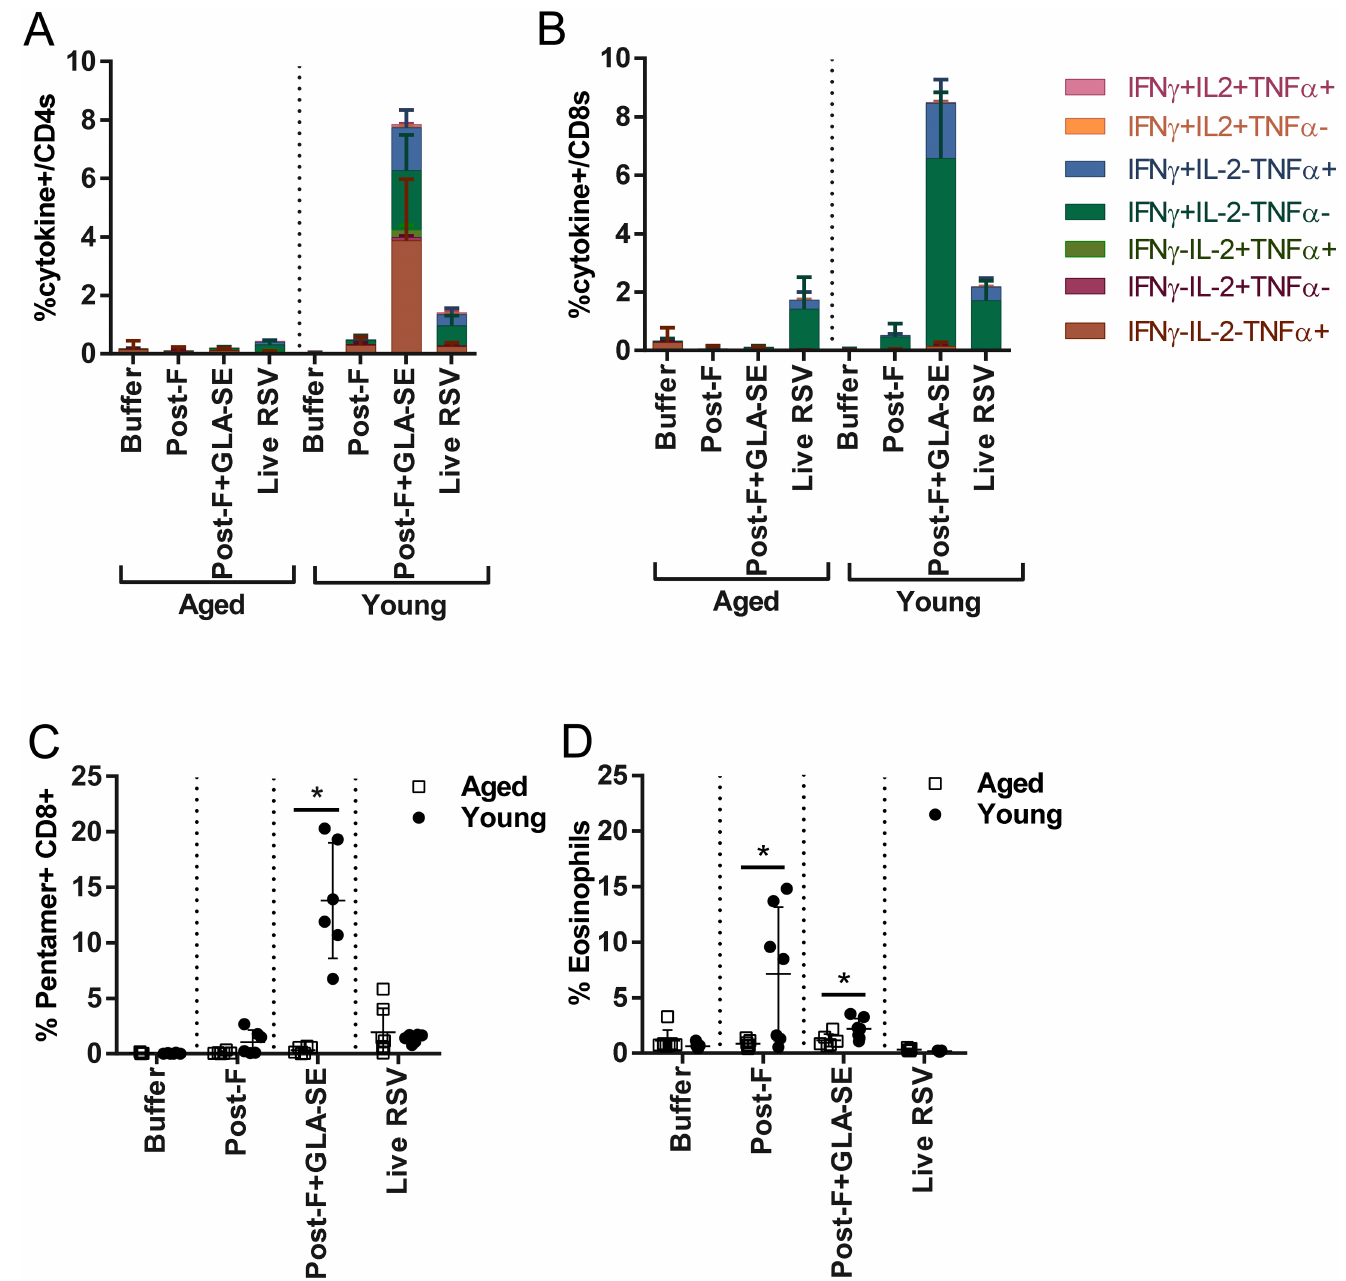
Fig 2. Lung T cell profile after RSV challenge in young and aged seronegative mice immunized with post-RSV F formulations. Young (7 weeks old) and aged (18 months old) BALB/c mice (n = 4 to 7 per group) were immunized i.m. at day 0 and day 21 with buffer alone, post-F (0.3 μ g) +/- GLA-SE (2.5 μ g/2%) adjuvant.A control group for natural infectionwas immunizedi.n. with live RSV (10 6 PFU) at day 0. At day 35, animals were challengedi.n. with 10 6 PFU of wt RSV A2. 4 days post-challenge(day 39), lung cells were isolated and stimulated with RSV F peptidepool to evaluateintracellular cytokine expressionby flow cytometry. Cells were surface stainedfor CD3 and CD8, intracellularly stained for IFN γ , TNF α , and IL-2, and analyzedon an LSR II for the frequency of responding(A) CD4+ and (B) CD8+ T cells. (C) The percentage of F85-93-pentamer+ CD8 T cells was determined by flow cytometry. (D) The percentage of lung eosinophilswas determinedby flow cytometry. For (C) and (D), the mean of individualvalues +/- SD is shown. For statistical analyses, aged and young mice were compared. * , P < 0.05.